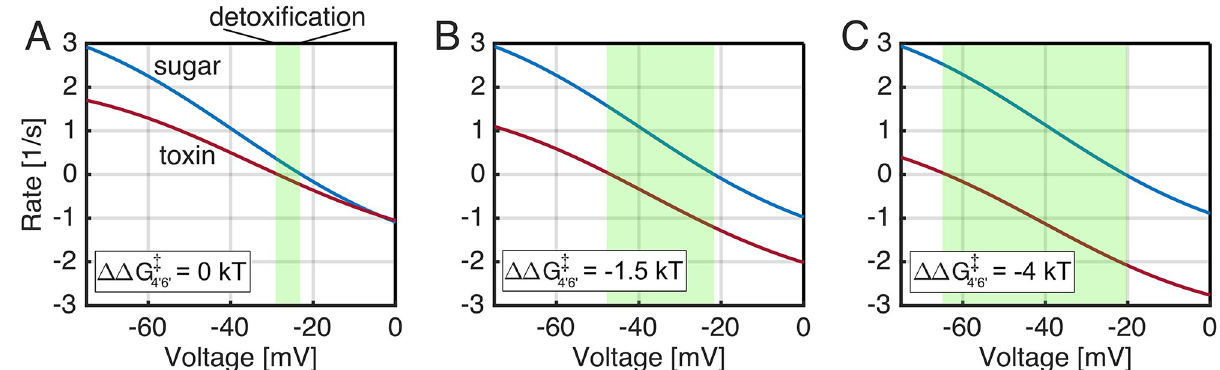
Fig 6. Two-point discrimination widens the detoxification regime. Toxin (red) and sugar (blue) pumping into the cytoplasm is plotted versus the = 0 (A) , -1.5 (B) , and -4 k B T (C) . The green regions indicate detoxification—negative toxin flow (export from cell) and membrane potential for DD G z 4 0 6 0 positive sugar flow (into the cell). As with all other models, there is a 1 k discrimination at the transport step in addition to changes in panels B and C B T to the 4 0 to 6 0 step. The curve for 0 k is the same as the curve labeled “pumping” in Fig 4B. B T